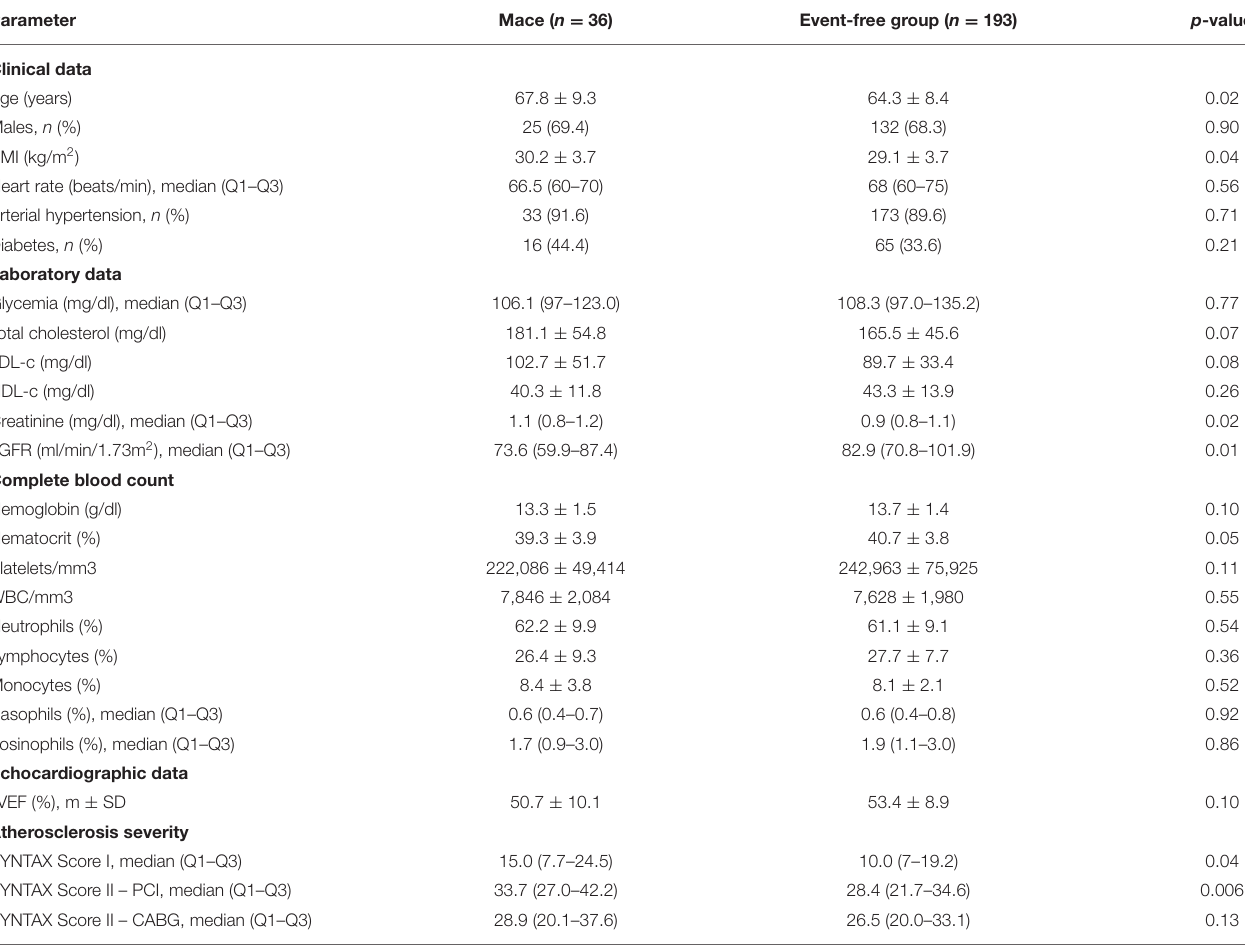
TABLE 2 | Clinical, laboratory, and angiographic characteristics of patients who reached the composite endpoint at 18 months follow-up. Parameter